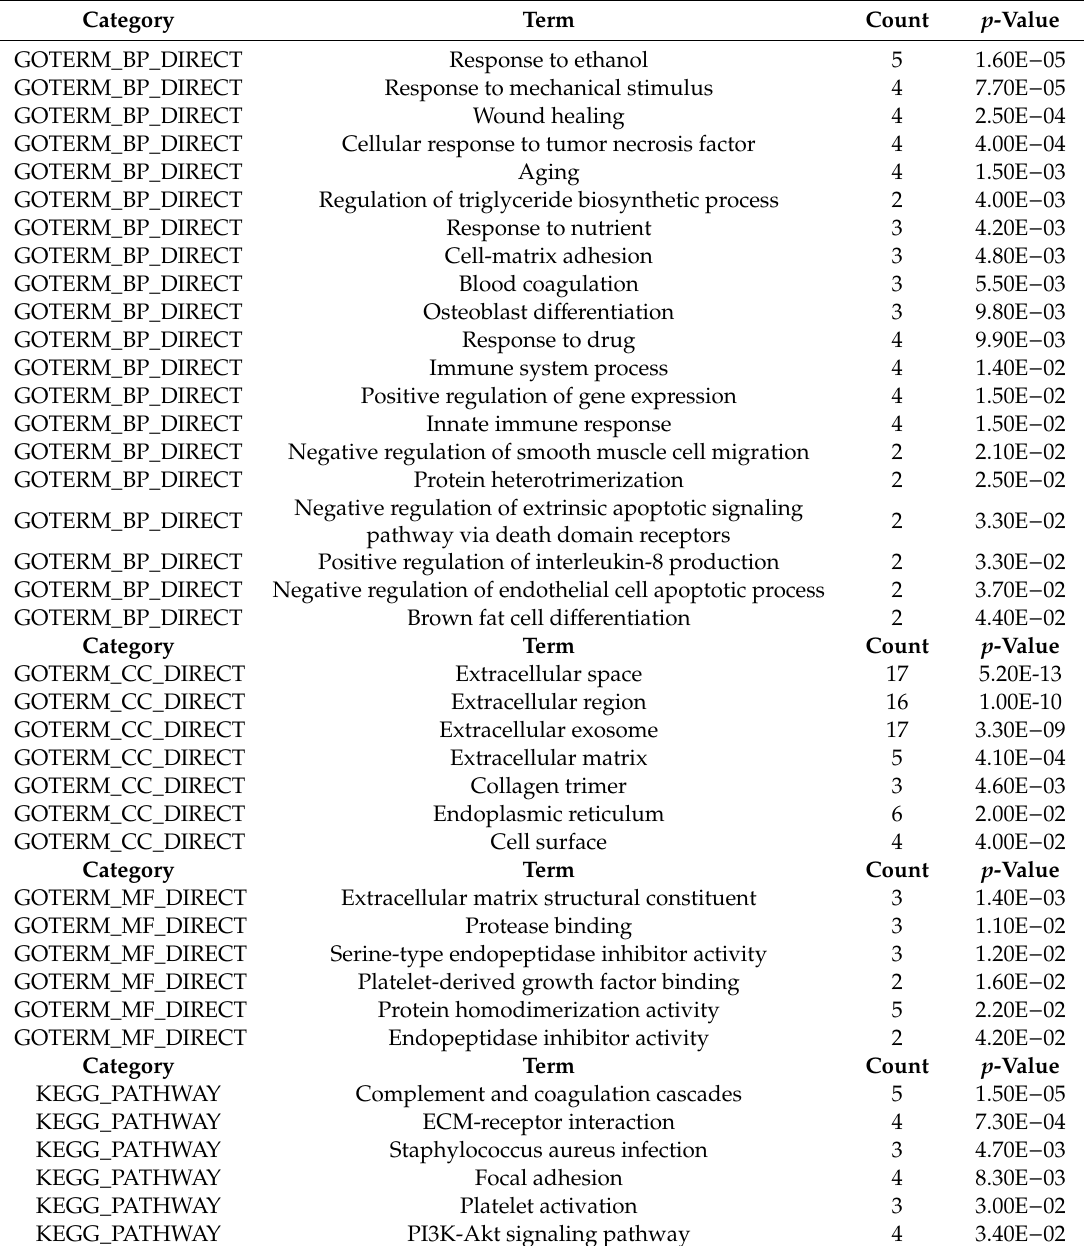
Table 3. Gene Ontology (GO) analysis was done with the most upregulated genes (see Table 2) in Gremlin-treated mice. This Table shows the most deregulated Cellular Component (CC), Biological Process (BP), Molecular Function (MF) and KEGG pathways. Control and Gremlin columns are group average FPKM values. FPKM is a unit of measuring gene expression. Fold change is the log2 fold change of the FPKM between the Control and Gremlin groups. q -values shown are p -values that have been adjusted using the Benjamini–Hochberg False Discovery Rate (FDR) approach to correct for multiple